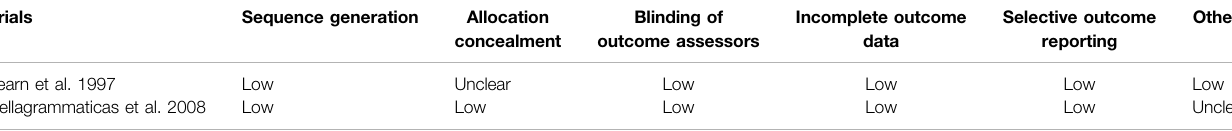
TABLE 4 | Cochrane Collaboration ’ s tool for quality assessment in randomized controlled trials.